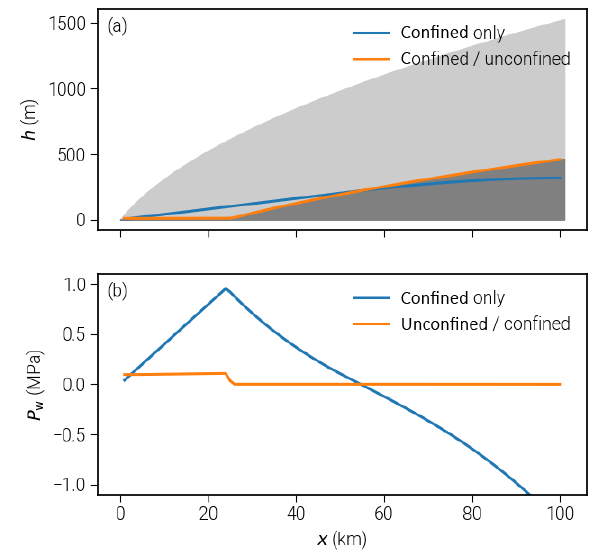
Figure 5. Advantages of using the confined–unconfined aquifer scheme (CUAS): values of head and water pressure for geometries with non-flat bedrock. (a) Computed head for the confined and com- bined scheme with ice geometry in the background. In the confined- only case, the head goes below bedrock. (b) Resulting water pres- sure; only for the combined scheme is the pressure always nonneg-